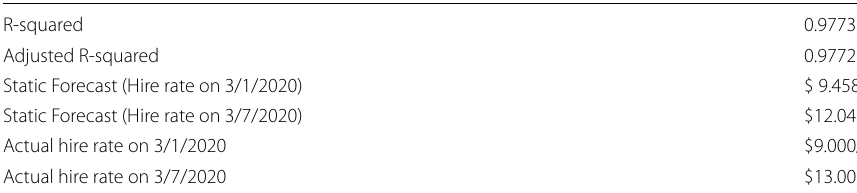
Table 6 Transatlantic R/V 72.000 dwt. Source : Elaboration by the authors R-squared 0.977332 Adjusted R-squared 0.977289